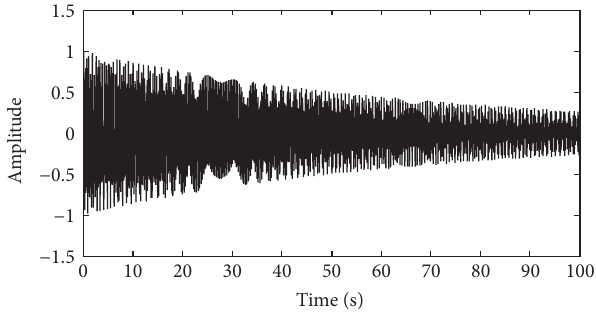
Figure 4: Displacement response of case 1.